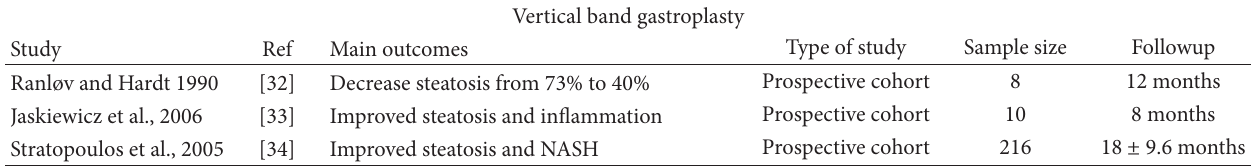
T 2: Summary of studies of VBG and their effect on